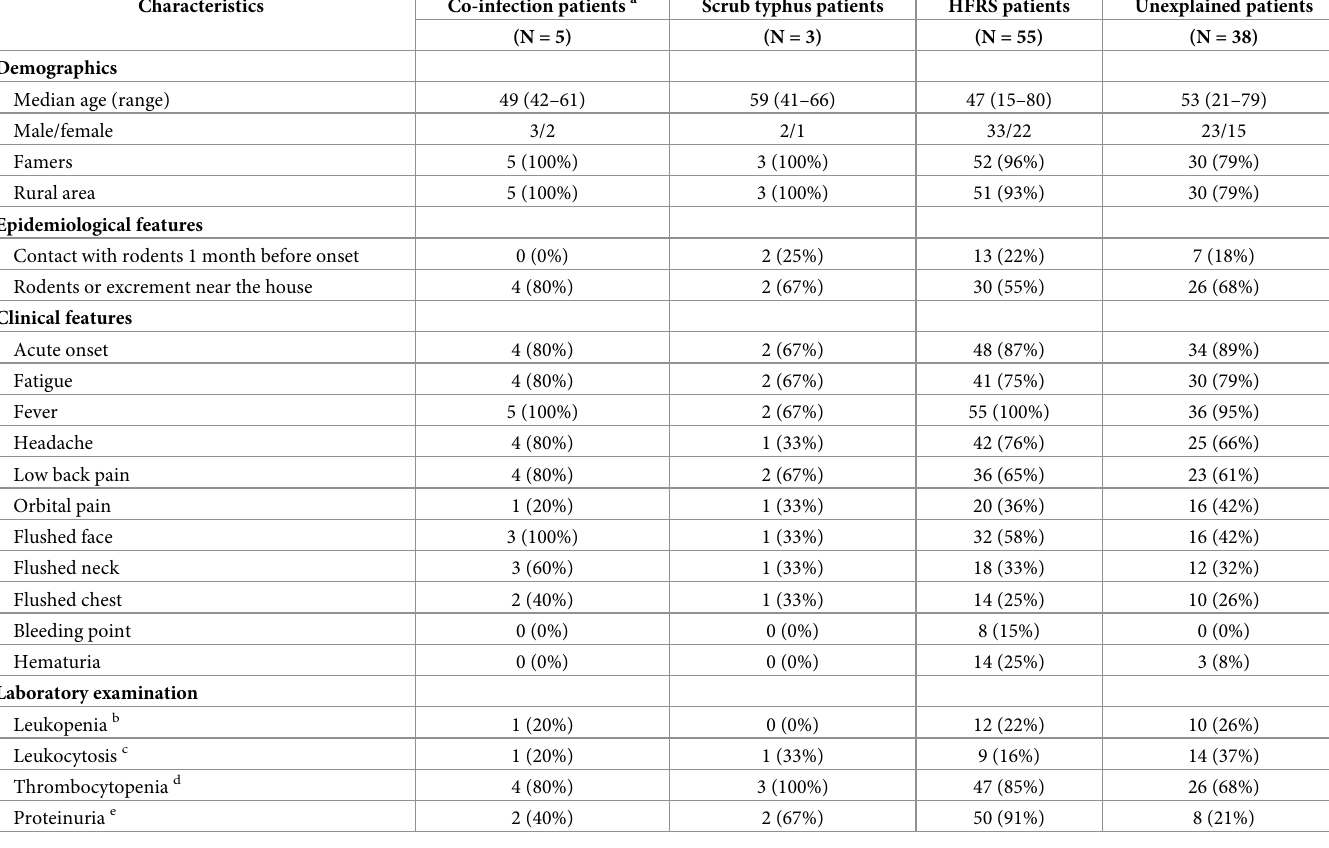
Table 2. Clinical characteristics and laboratory diagnosis of 101 suspected HFRS